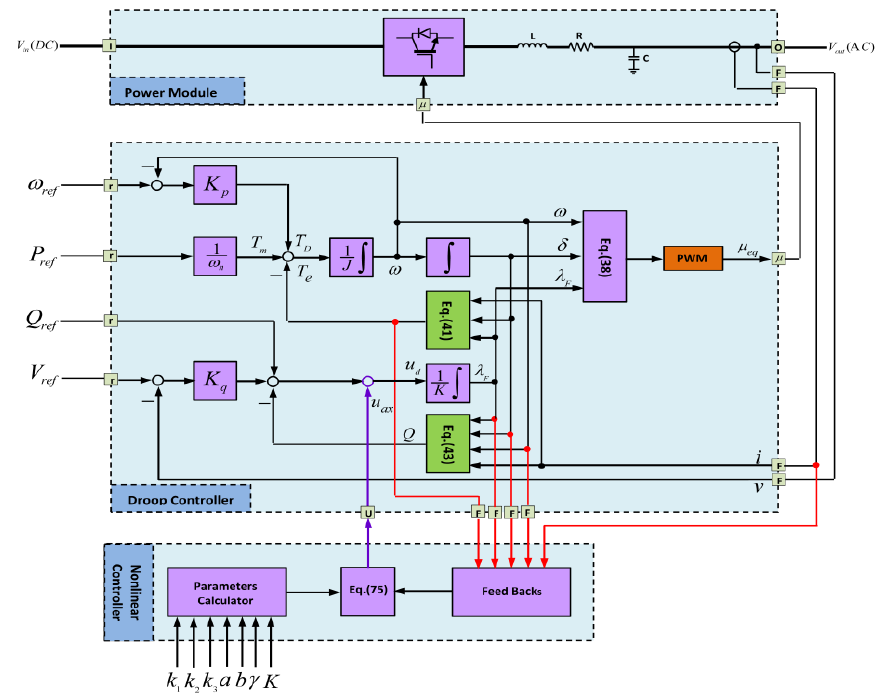
Figure 7. Location of proposed controller on VISMA model.